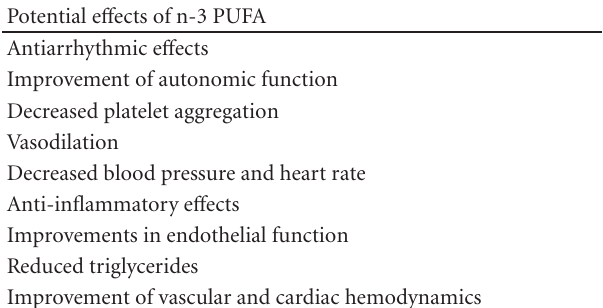
Potential e ff ects of n-3 PUFA Antiarrhythmic e ff ects Improvement of autonomic function Decreased platelet aggregation Vasodilation Decreased blood pressure and heart rate Anti-inflammatory e ff ects Improvements in endothelial function Reduced triglycerides Improvement of vascular and cardiac